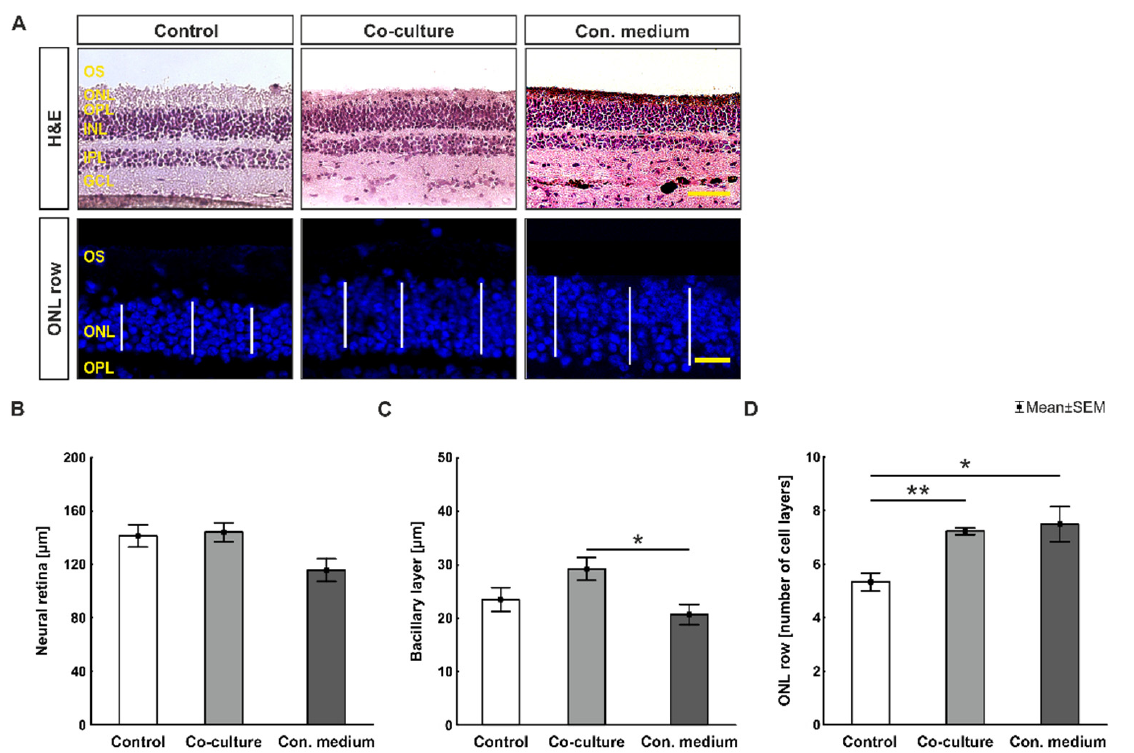
Figure 2. Co-cultivation of the neuroretina with ppRPE cells increased the number of cells in the ONL. ( A ) Upper panel: representative pictures of H&E-stained retina samples of the three groups investigated after 8 days in culture. Bottom panel: representative images of the ONL with DAPI- labeled cell nuclei (blue). To count the cell layers of the ONL, they were marked with three white bars and counted. ( B ) Neuroretina thickness was not altered in the three groups. ( C ) The bacillary layer thickness of the co-culture retinae was comparable to controls, while a significantly thinner bacillary layer was detected in the conditioned medium ( p = 0.024) groups in comparison to co-culture samples. ( D ) The number of cell layers in the ONL was significantly higher in the co-culture ( p = 0.003) and conditioned medium group ( p = 0.030) compared to control retinae. OS, photoreceptor outer segments; ONL, outer nuclear layer; OPL, outer plexiform layer; INL, inner nuclear layer; IPL, inner plexiform layer; GCL, ganglion cell layer. Scale bars: H&E: 50 µ m, IF: 20 µ m, values are presented as mean ± SEM, n = 8/group, * p < 0.05, ** p <